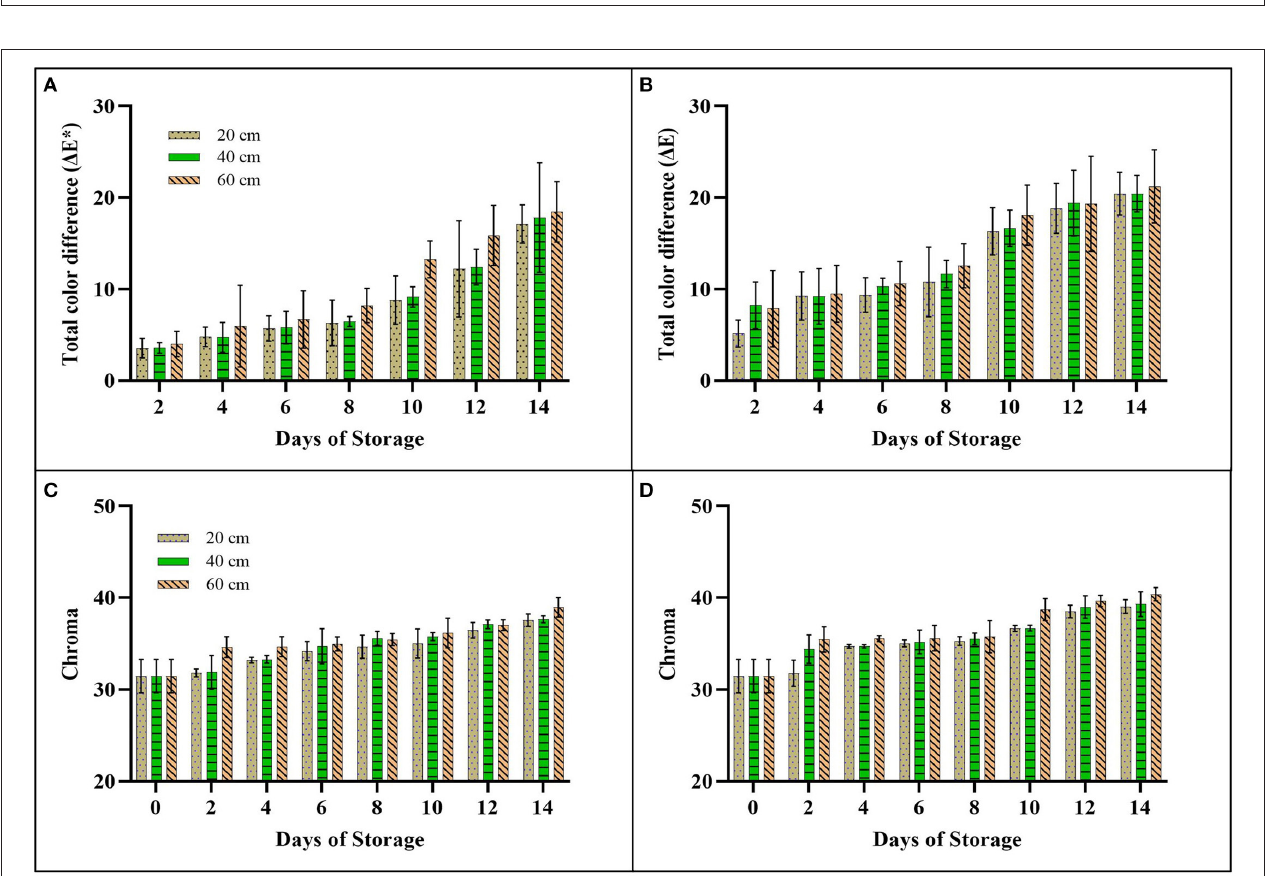
FIGURE 8 | Single linear regression between BS and b* at different drop heights (20, 40, and 60cm) during 14 days at (A) 10 ◦ C and (B) 22 ◦ C storage conditions.